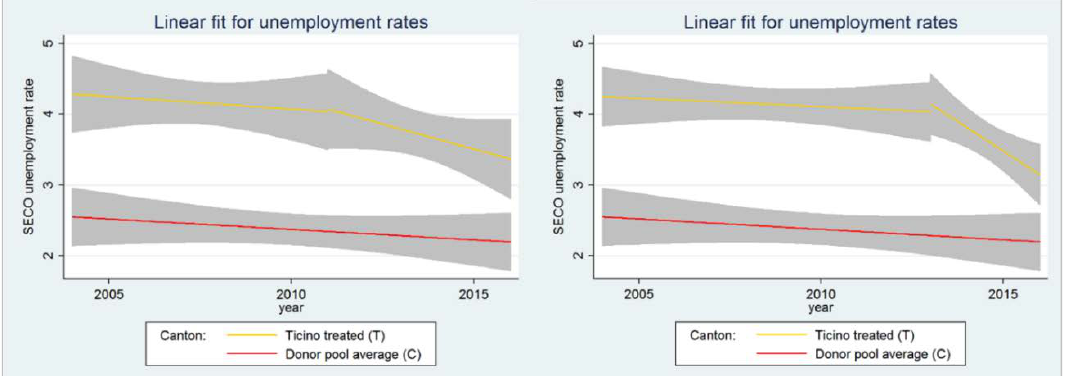
Figure 4. Linear fits for Ticino and donor pool with cut-offs in 2011 (left) and 2013 (right).